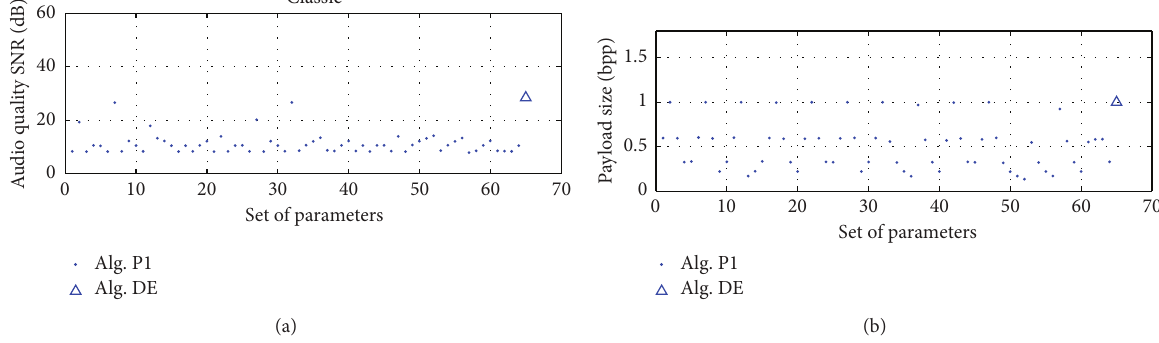
Figure 6: The performance of the 64 prediction coefficient sets and optimal prediction coefficient set for classic audio.